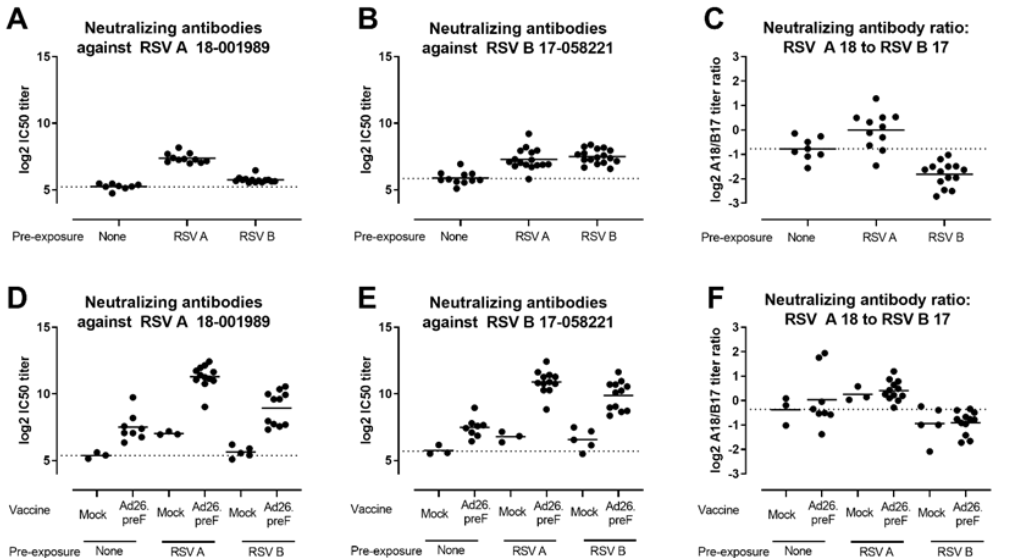
Figure 2. Ad26.RSV.preF induces RSV A and RSV B subtype-specific neutralizing antibodies in both RSV A and RSV B pre-exposed mice. Mice were pre-exposed to RSV A 18-001989 or RSV B 17-058221 12 weeks prior to immunization with 10 8 vp Ad26.RSV.preF (n = 12), or empty Ad26 vector (mock, n = 5). As controls, naïve mice were immunized with 10 9 vp Ad26.RSV.preF (n = 8), or empty Ad26 vector (mock, n = 3). Neutralizing antibodies titers against RSV A 18-001989 ( A , D ) or RSV B 17-058221 ( B , E ) were determined by MN VNA on serum isolated at week 12, prior to immunization ( a , b ), and at week 16, 4 weeks posts immunization ( D , E ). Log2 ratios between RSV A and RSV B VNT are depicted ( C , F ). The average responses in mock immunized naïve animals are indicated with dotted lines. Mean responses per group are indicated with horizontal lines. Note some data points are missing due to insufficient serum availability, dropout of animals from the study or experimental failure.